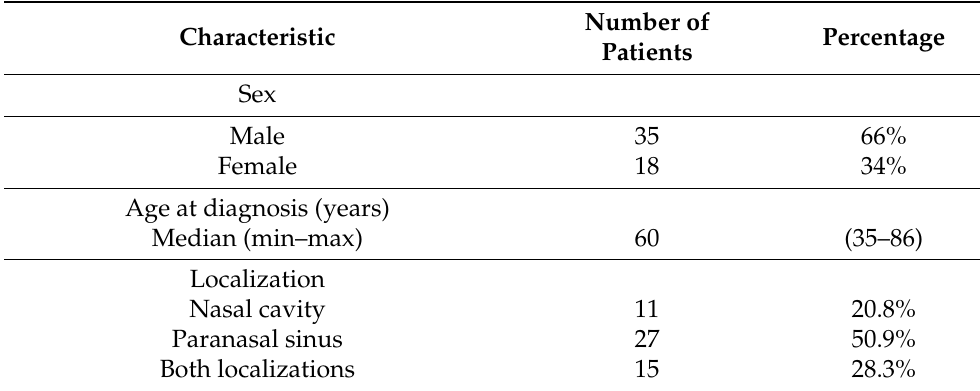
Table 1. Patient characteristics ( n =